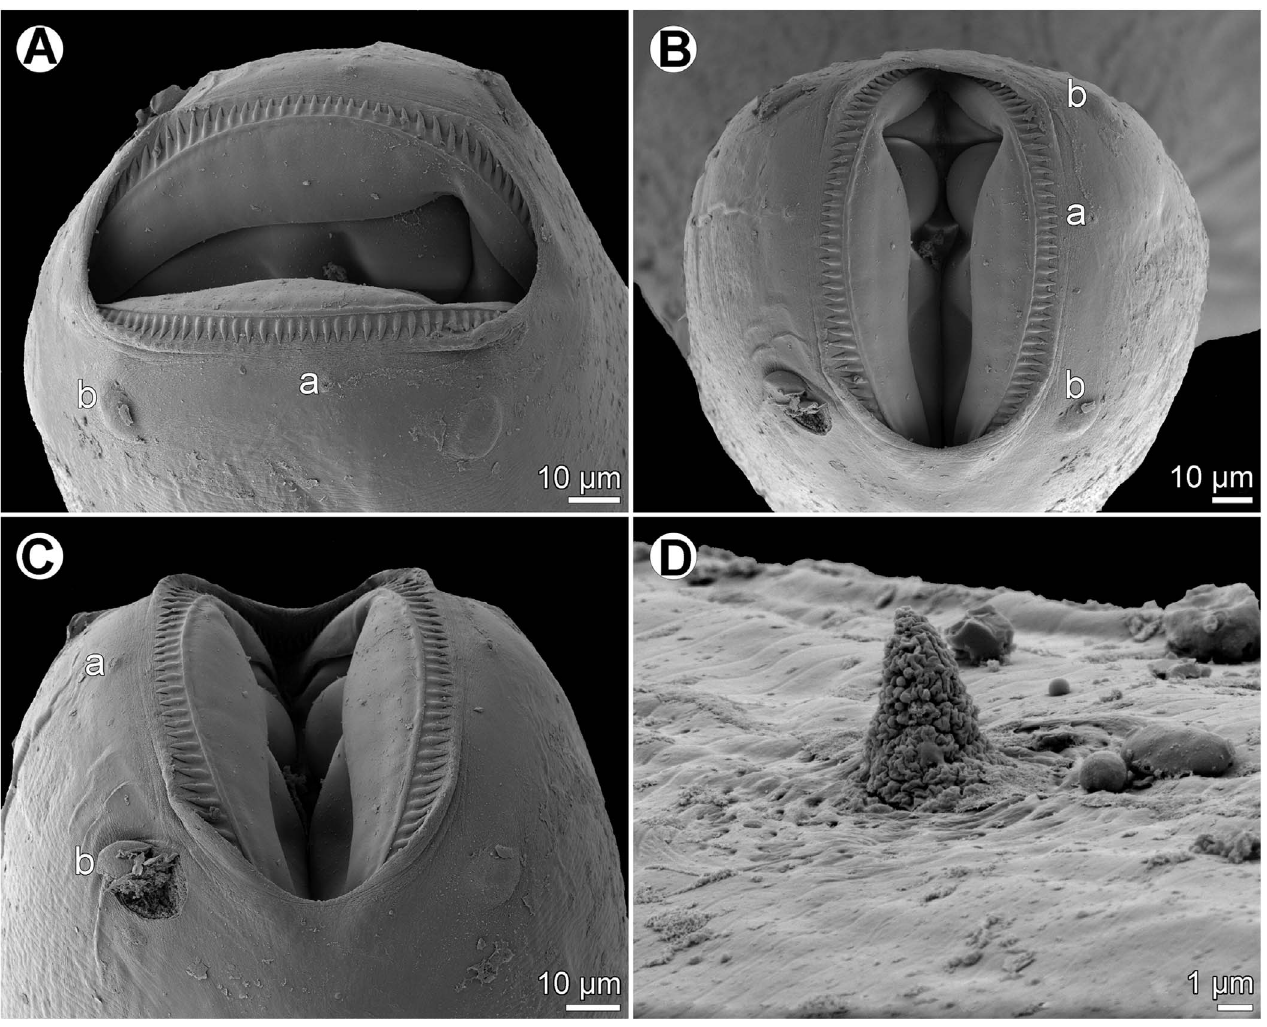
Figure 14. Cucullanus petterae n. sp., scanning electron micrographs of nongravid female from Epinephelus fasciatus . (A, B) Cephalic end, sublateral and apical views, respectively; (C) cephalic end, dorsoventral view; (D) deirid. (a) Amphid; (b) cephalic